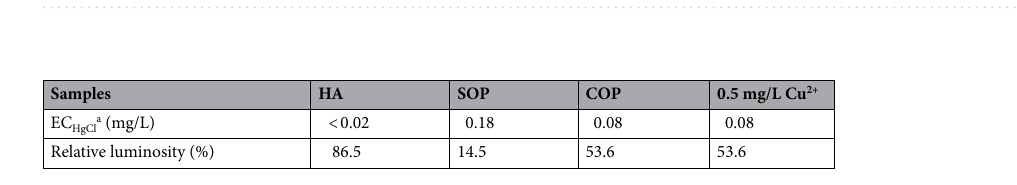
Table 3. Effect of the number of cycles on TOC removal and leaching of the metal content in the Cu/Ce– Al 2 O 3 /O 3 process.